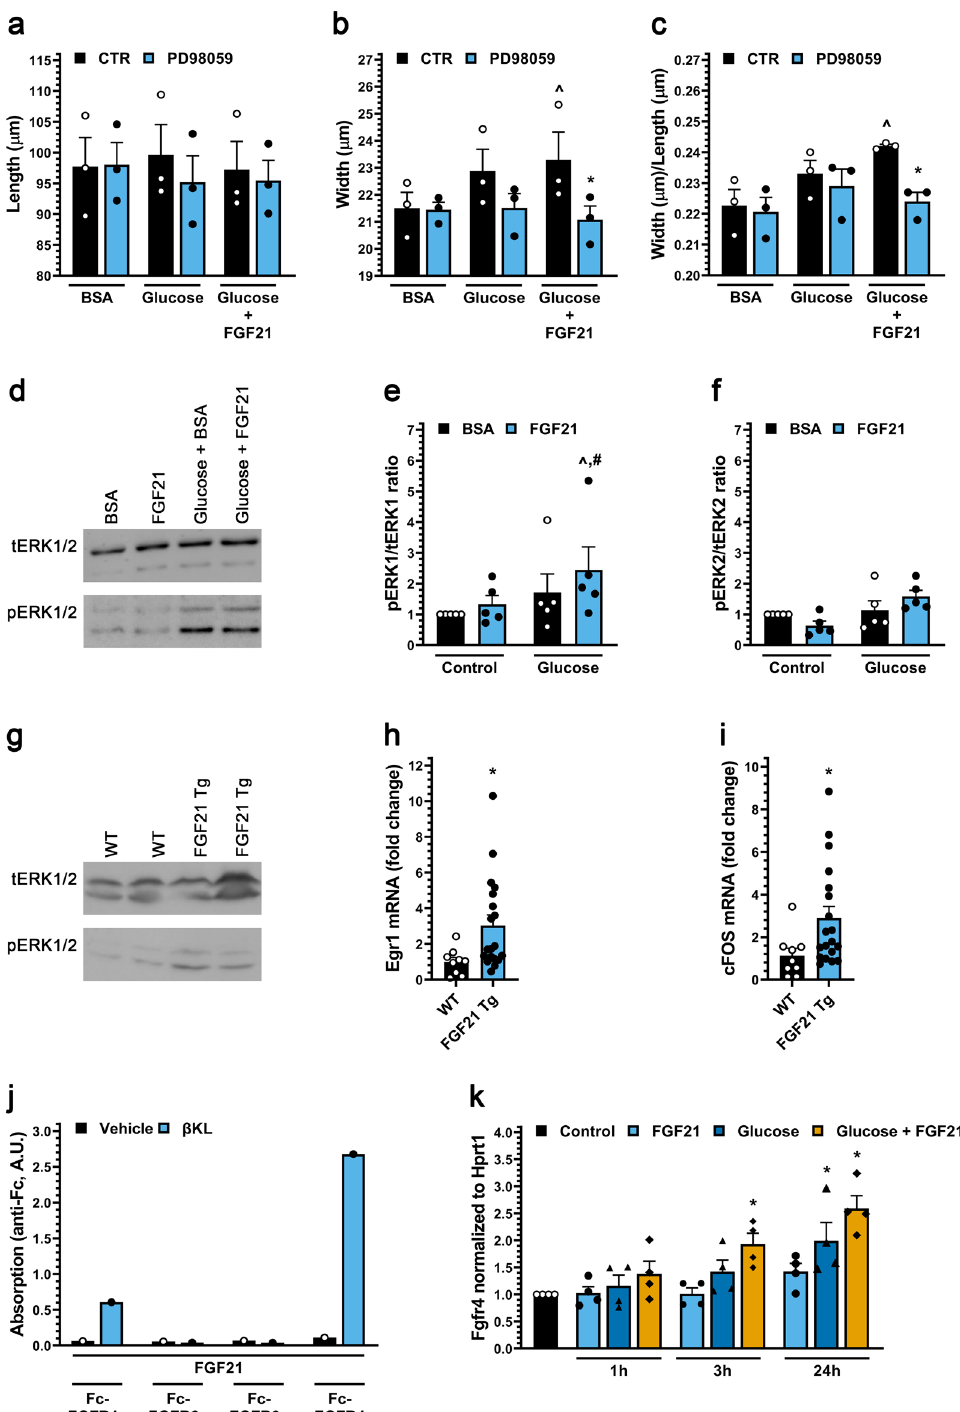
Figure 3. FGF21 activates ERK1/2 in cultured cardiac myocytes in the presence of high glucose and in heart tissue of mice. ( a – c ) Length, width and width to length ratio for ARVMs treated with BSA (control), FGF21 (25 ng/ml), increased glucose and/or the MEK inhibitor PD98059 (20 µM) for 48 h. Bars and colored symbols indicate average mean and means of independent experiments using different myocyte preparations, respectively. ( d – f ) Western blot analysis of ARVMs treated with BSA (control) or mouse recombinant FGF21 (25 ng/ml) with or without 10 mM glucose for 6 h. ERK1 is p44 and ERK2 is p42. ( g ) Analysis of cardiac tissue from FGF21 Tg mice and wild-type littermates at 8–12 weeks of age by Western blotting. ( h , i ) qRT-PCR for Egr-1 and c-Fos mRNA using total RNA from heart tissue of FGF21 Tg mice and wild-type littermates at 8–12 weeks of age. ( j ) Binding of 1 µg of soluble β-klotho (βKL) or PBS, 500 ng of Fc-tagged FGFR 1c, 2c, 3c, or 4 to 96-well plates coated with 200 ng of FGF21. ( k ) qRT-PCR for FGFR4 mRNA using total RNA isolated from ARVMs treated with BSA (control), FGF21 (25 ng/ml), and/or increased glucose (15.6 mM total). Comparison between groups was performed in form of a one-way ( a – c , k ) or two-way ( e – f ) ANOVA followed by post-hoc Tukey test or a two tailed t-test ( h , i ). All values are expressed as mean ± SEM. ( a – c ) N = 3, ^ p ≤ 0.05 vs. BSA CTR, *p ≤ 0.05 vs. Glucose + FGF21 CTR; ( e , f ) N = 5, ^ p ≤ 0.05 vs. BSA CTR, # p ≤ 0.05 vs. FGF21 CTR; ( h, i ) N = 9−19, *p ≤ 0.05 vs. WT; ( k ) N = 4, *p ≤ 0.05 vs. CTR. All Western blots are cropped, and original blots are presented in Supplementary Fig.